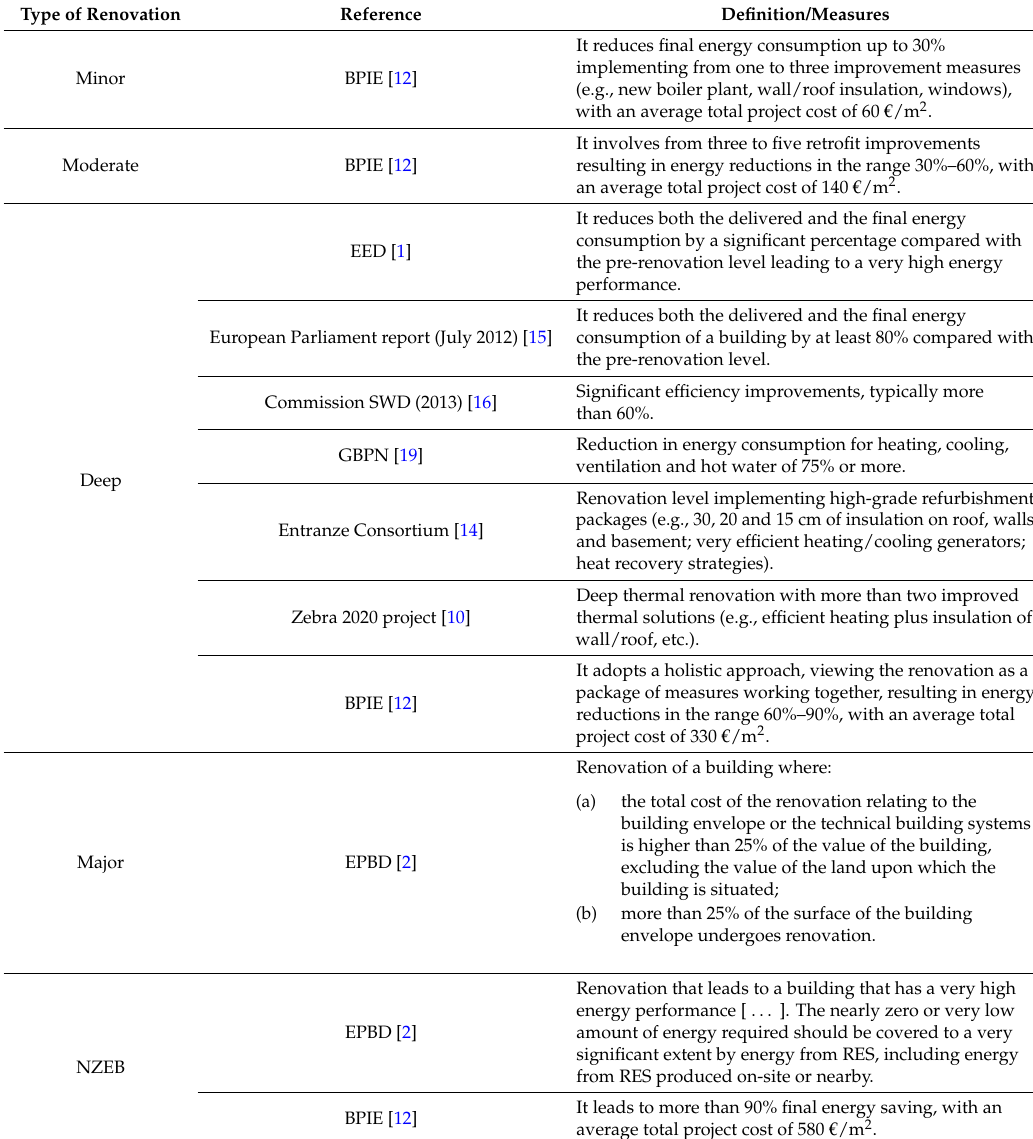
Table 1. Summary of definitions of minor, moderate, deep, major and NZEB renovation. NZEB: nearly zero energy building; BPIE: Buildings Performance Institute Europe; EED: Energy Efficiency Directive; SWD: Staff Working Document; GBPN: Global Buildings Performance Network; EPBD: Energy Performance of Building Directive; and RES: renewable energy